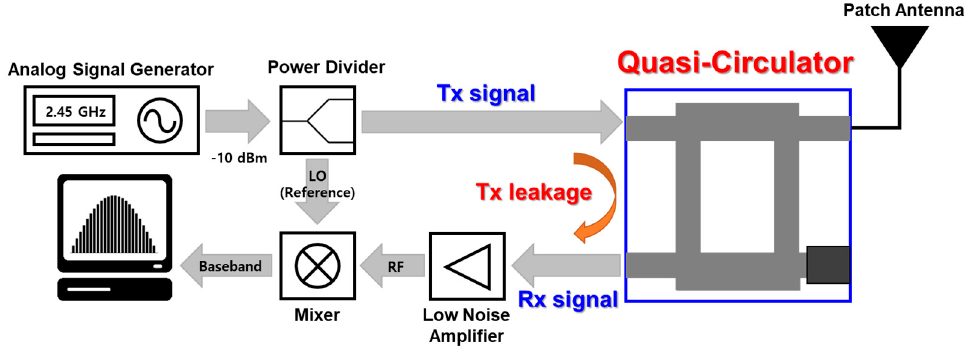
Figure 10. Measurement setup for 2.45 GHz monostatic Doppler radar sensor using the